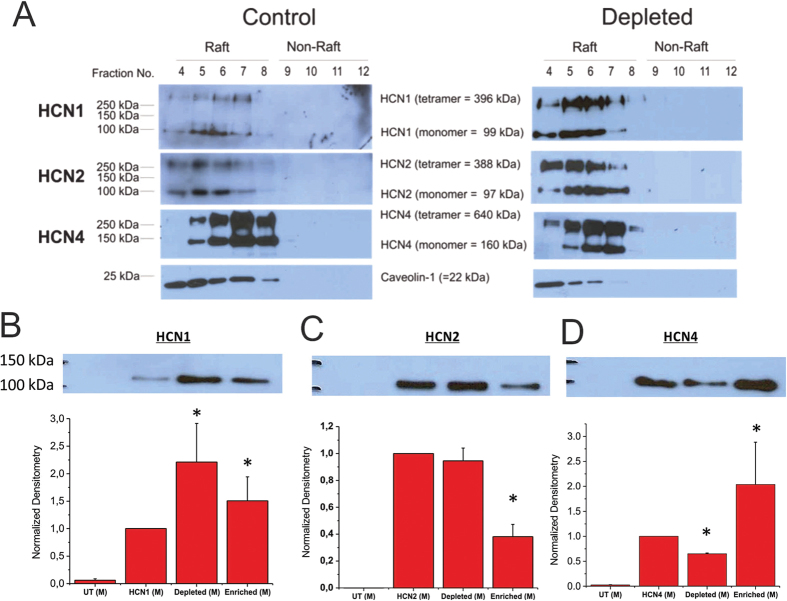
Distribution of HCN channels in CHO-K1 cell membranes.(A) HCN1, HCN2 and HCN4 channels were all found to be distributed into low-density fractions typically associated with lipid-raft domains isolated by discontinuous sucrose gradient methods. The distribution of these channels was unchanged upon treatment with MβCD to deplete membranes of cholesterol. (n = 3). Biotinylation assays were used to assess the effect of cholesterol modulation HCN channel trafficking to the membrane (B–D). We observed isoform dependent effects of on trafficking upon cholesterol depletion by MβCD or enrichment by MβCD/cholesterol. (n = 3; P < 0.05).